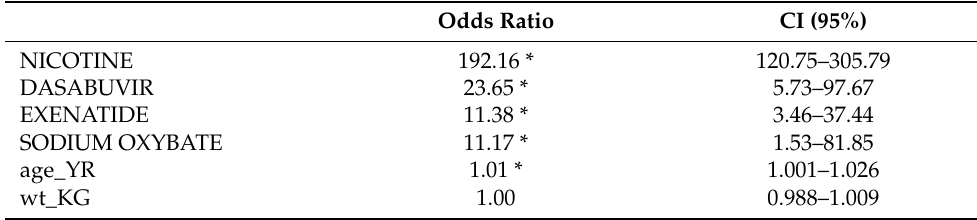
Table 4. Results of a multiple logistic regression analysis using the female data